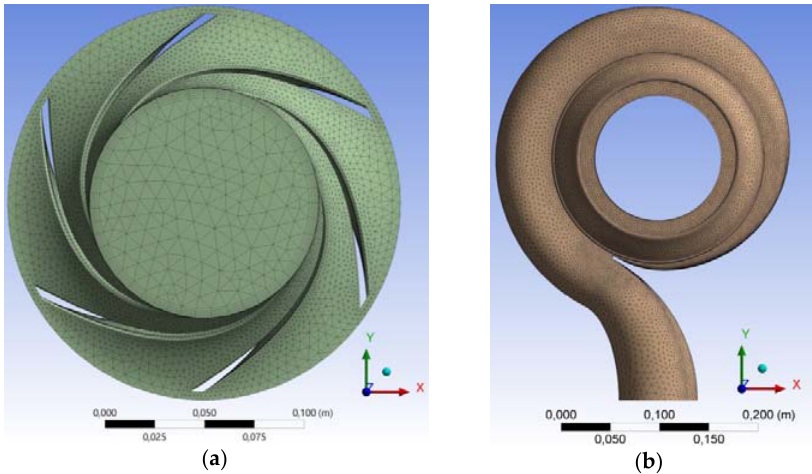
Figure 1. Representation of 1.2 M mesh level for ( a ) impeller front; ( b ) volute